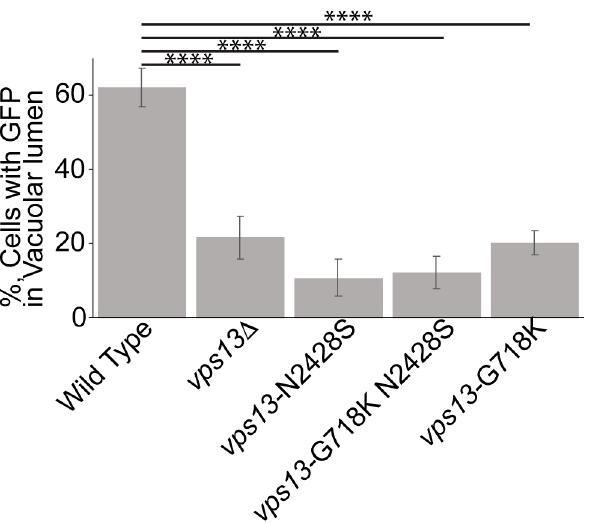
Figure 6. The vps13-G718K mutant is defective in ER-phagy. Quantification of ER-phagy in different strains: wild type (GCY5), vps13 ∆ (JSP846), vps13-N2428S (JSP851), vps13-G718K N2428S (JSP881), and vps13-G718K (JSP883). Percentages shown are the averages of at least four independent experiments and over 150 cells per strain were scored in each experiment. Error bars are one standard deviation. **** indicates comparison to wild type, p <